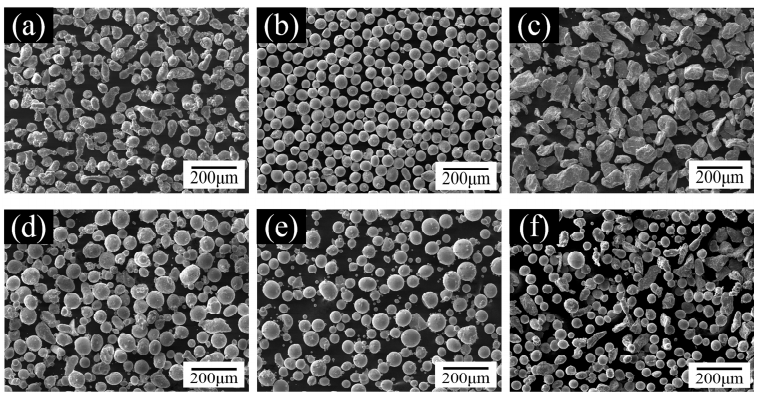
Figure 1. SEM micrograph of the powders: ( a ) Al, ( b ) Co, ( c ) Cr, ( d ) Fe, ( e ) Ni, and ( f )